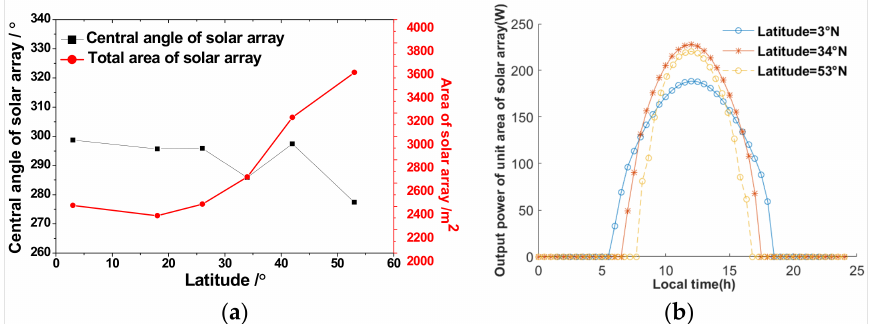
Figure 14. ( a ) The optimized area and central angle of solar arrays for different latitudes. ( b ) Unit area of solar arrays for different